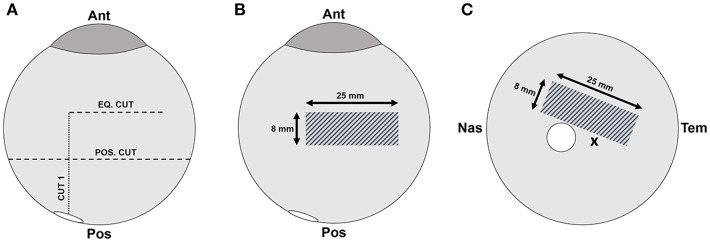
(A) Scleral dissection methods used to create a rectangular retinal window (gray crosshatch) in the (B) equatorial and (C) posterior regions. The location of the optic nerve head is shown as a white circle, and the fovea marked with an “x”.